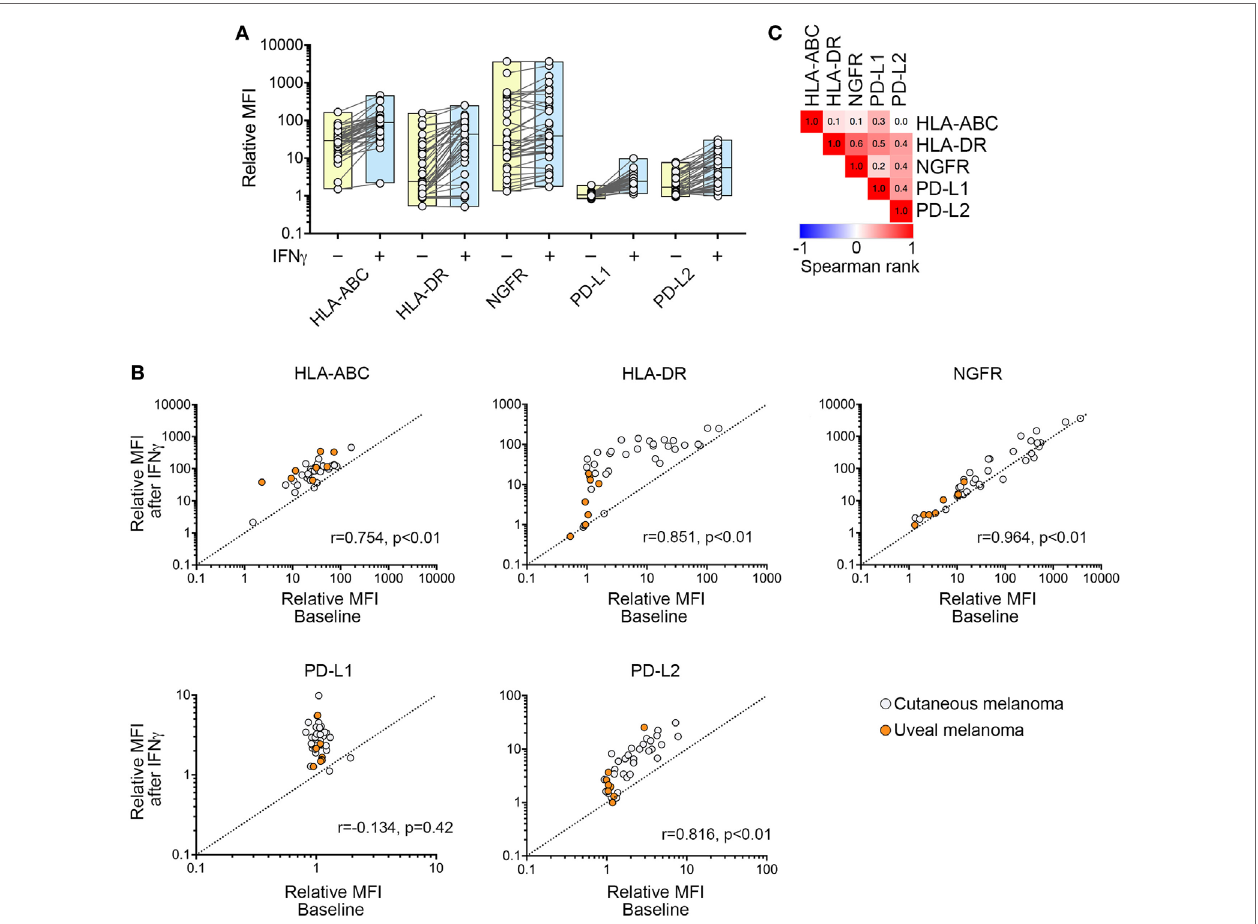
FigUre 3 | Expression of cell surface markers in response to interferon- γ (IFN γ ) treatment. (a) Change in HLA-ABC, HLA-DR, nerve growth factor receptor (NGFR), PD-L1, and PD-L2 cell surface expression [relative mean fluorescence intensity (MFI)] after exposure to IFN γ . Each dot shows one cell line before ( − ) and after ( + ) IFN γ stimulation with box plots showing the range and median. (B) Correlation of baseline and IFN γ -induced cell surface expression of HLA-ABC, HLA-DR, NGFR, PD-L1, and PD-L2. Each dot represents one cell line. Spearman’s rank correlation coefficient and p values are shown. (c) Correlation matrix showing Spearman’s rank correlation analysis between IFN γ -induced expression of HLA-ABC, HLA-DR, NGFR, PD-L1, and PD-L2. Spearman rank correlation values are shown within the similarity